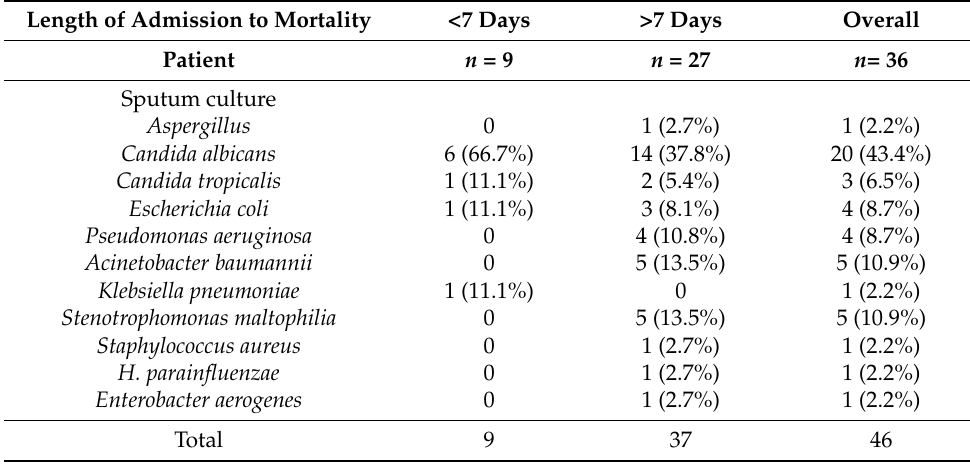
Table 3. The pathogens of co-infections of COVID-19 mortality cases.